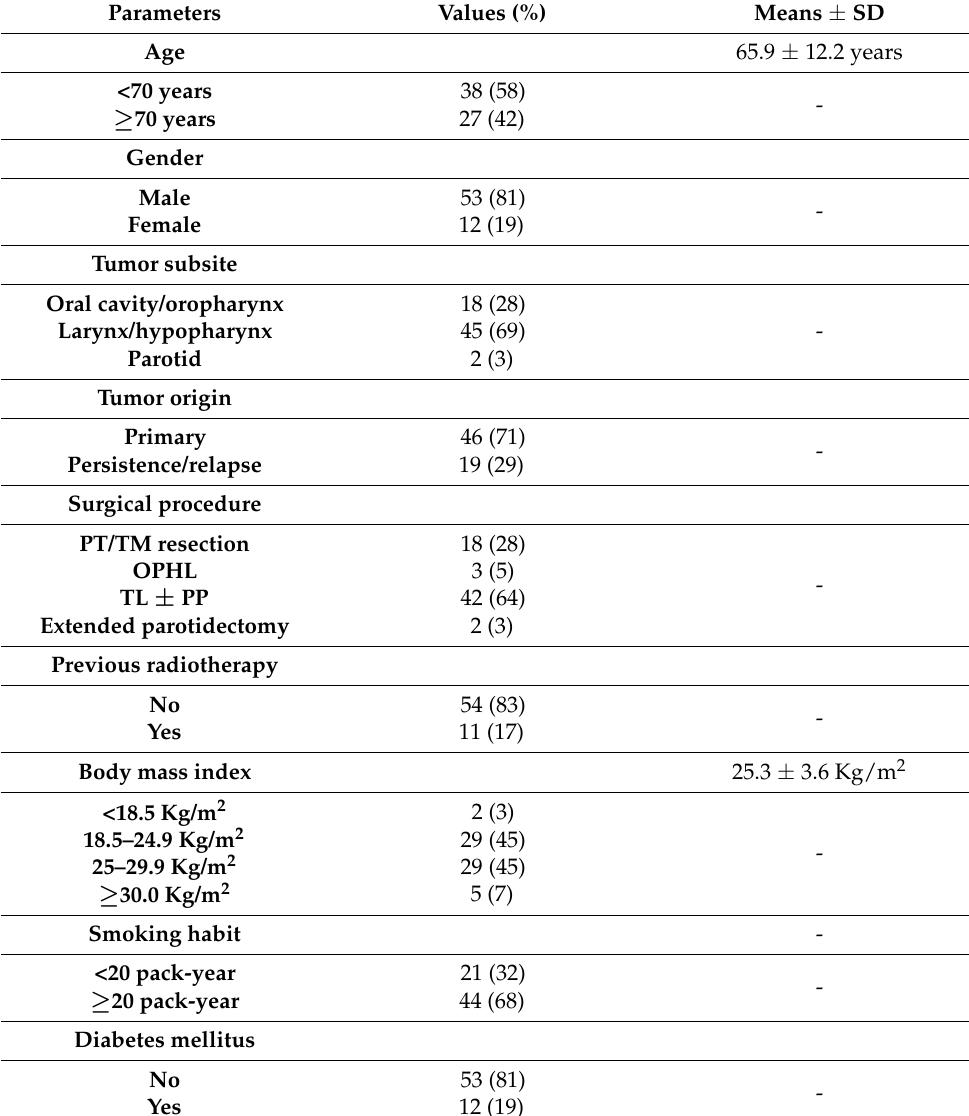
Table 1. Patient characteristics. PT: pull-through; TM: trans-mandibular; OPHL: open partial hori- zontal laryngectomy; TL: total laryngectomy; PP: partial pharyngectomy.